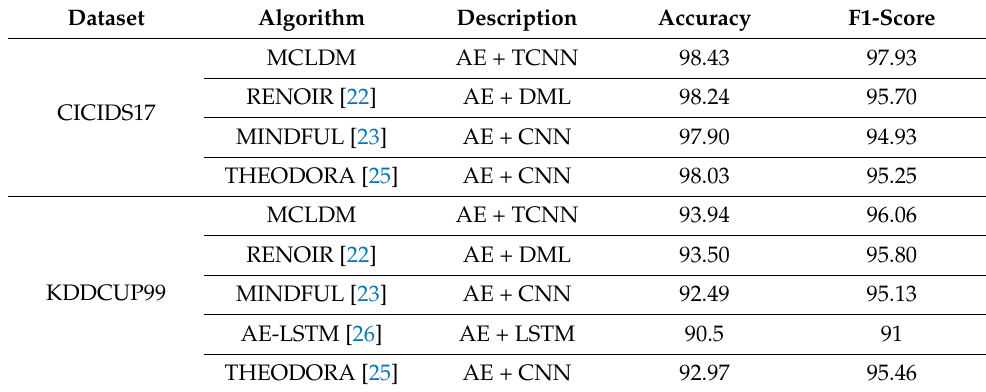
Table 6. Accuracy and F1-cores tested at CICIDS17 and